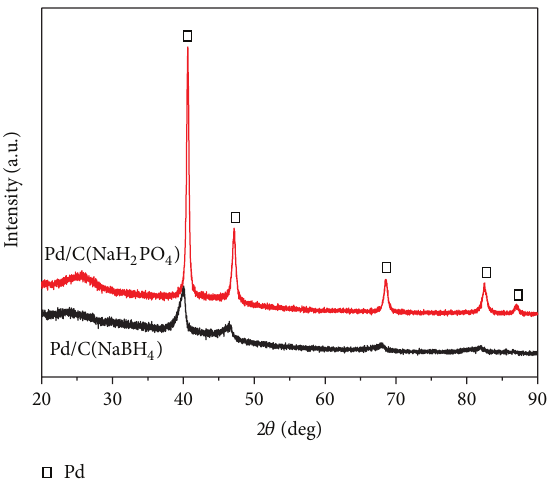
Figure 2: XRD patterns of Pd/C (NaBH 4 ) and Pd/C (NaH 2 PO 2 ).